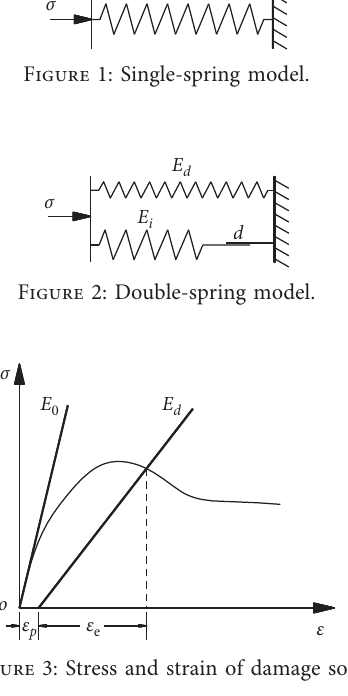
Figure 1: Single-spring model.